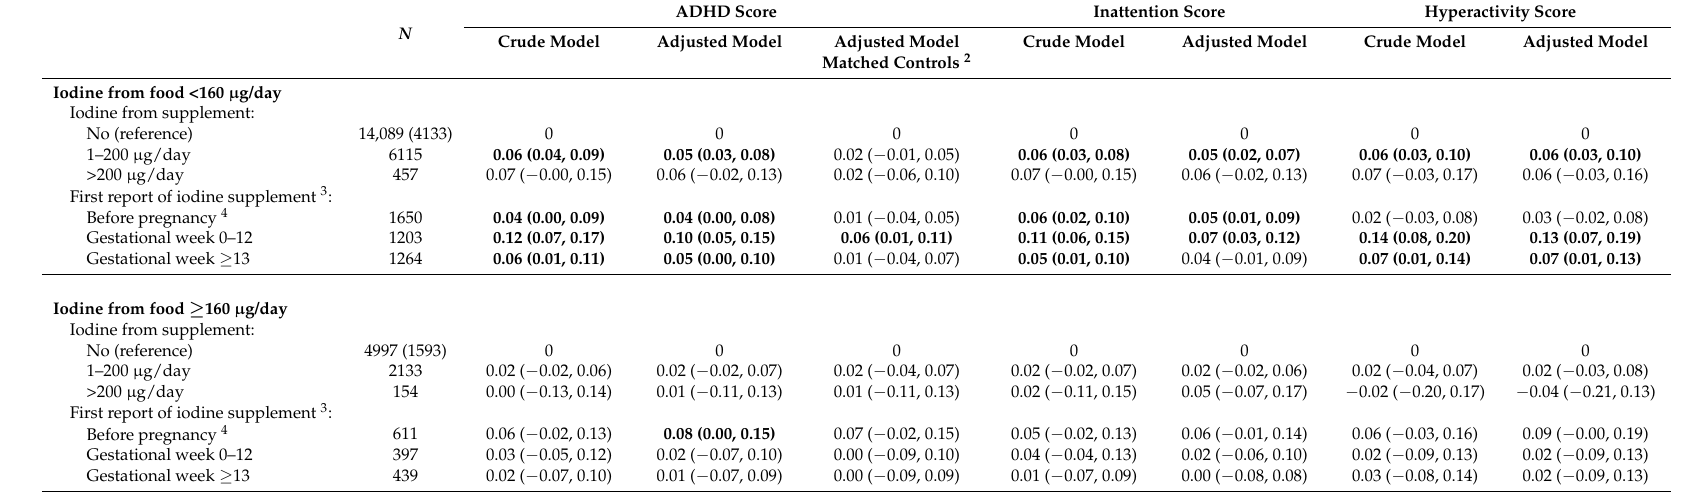
Table 4. Use of iodine-containing supplements in pregnancy and maternally reported ADHD symptoms at eight years of age ( n = 27,945) 1 . ADHD Score Inattention Score Hyperactivity Score N Crude Model Adjusted Model Adjusted Model Crude Model Adjusted Model Crude Model Adjusted Model Matched Controls